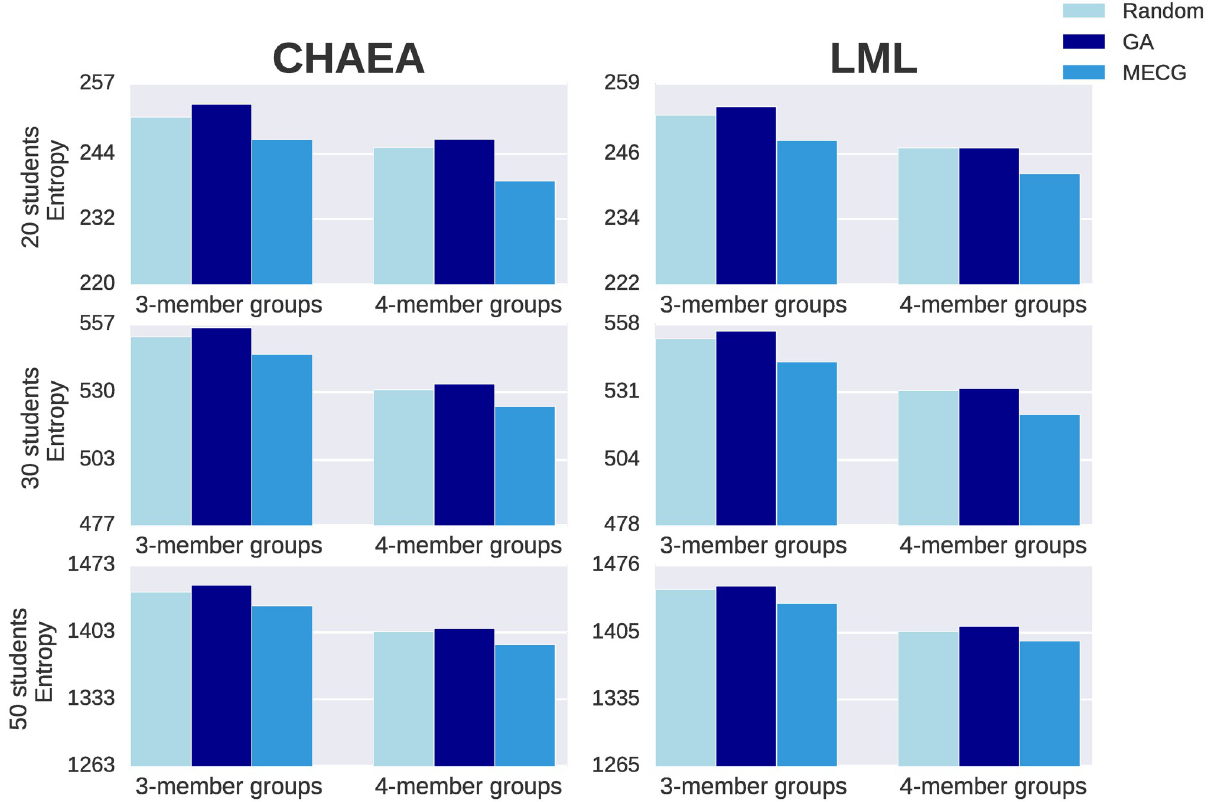
Fig 3. MECG partitions have lower entropy. We generate 15 random classrooms of different sizes (5 of 20 students, 5 of 30 students and 5 of 50 students), in which students have been generated following a normal distribution, given the mean and standard deviation of learning styles/patterns of both CHAEA [54] and LML [30] questionnaires. For each generated classroom, we search for the optimal partition of students both into 3-member groups and 4-member groups, separately, using our approach to form Minimum Entropy Collaborative Groupings (MECG); and, for each size, we compute the mean of the entropies of each optimal partition of the 5 classrooms (The standard deviation is not shown because it is too low to be appreciated). Analogously, we compute the mean entropy for each size with two other approaches to compare with: (i) grouping the students randomly; (ii) a genetic algorithm that we elaborated based on the work by Moreno et al. [39]. Observe that, in all the cases (different classroom size, 3-member or 4-member groups, CHAEA or LML), the entropy of our approach MECG is lower.